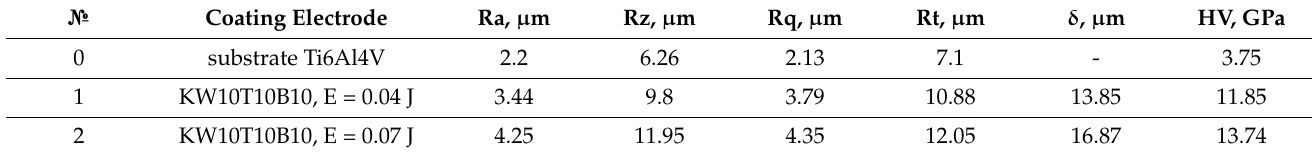
Figure 3. Cross-section microphotographs of coatings, E = 0.04 J. ( a ) KW10T10B10; ( b ) TiB 2 –TiAl nano . Table 1. Roughness Ra, Rz, Rq, Rt, thickness δ and microhardness HV of coatings on Ti6Al4V